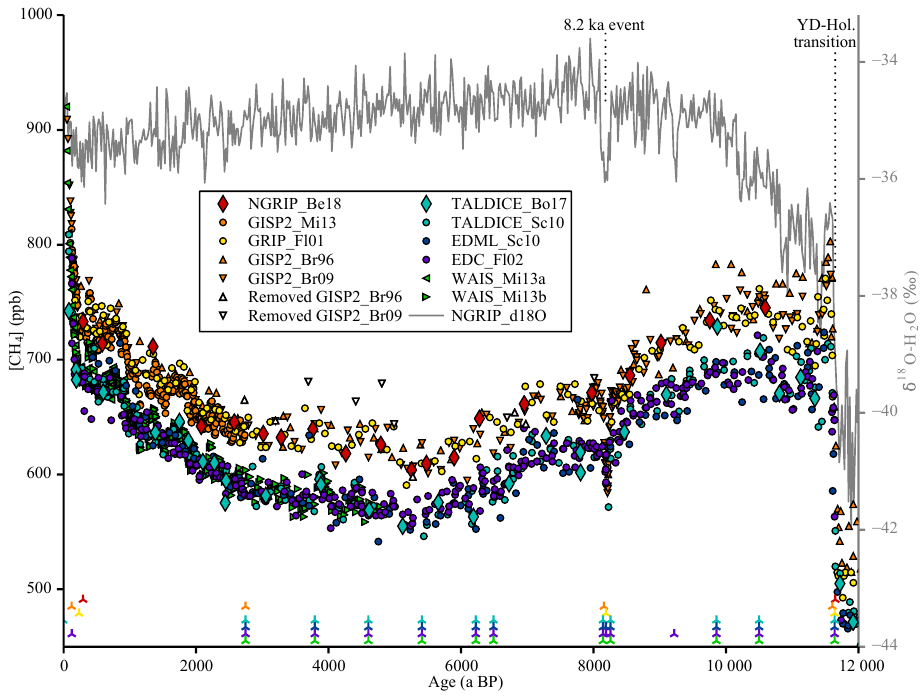
Figure 1. CH 4 concentration data compilation. Discrete [CH 4 ] data over the Holocene used for the CH 4 data compilation on synchronised gas age scales and corrected for offsets among data sets (references are listed in Table 1). The δ 18 O-H 2 O data from the layer-counted NGRIP ice core have been used as an absolute time marker for fast climatic changes (e.g. the Younger Dryas–Holocene transition and the 8.2ka event) assuming an essentially synchronous change in rapid temperature variations and atmospheric CH 4 . The markers at the bottom of the plot indicate the tie points of the synchronised age scales (see Table